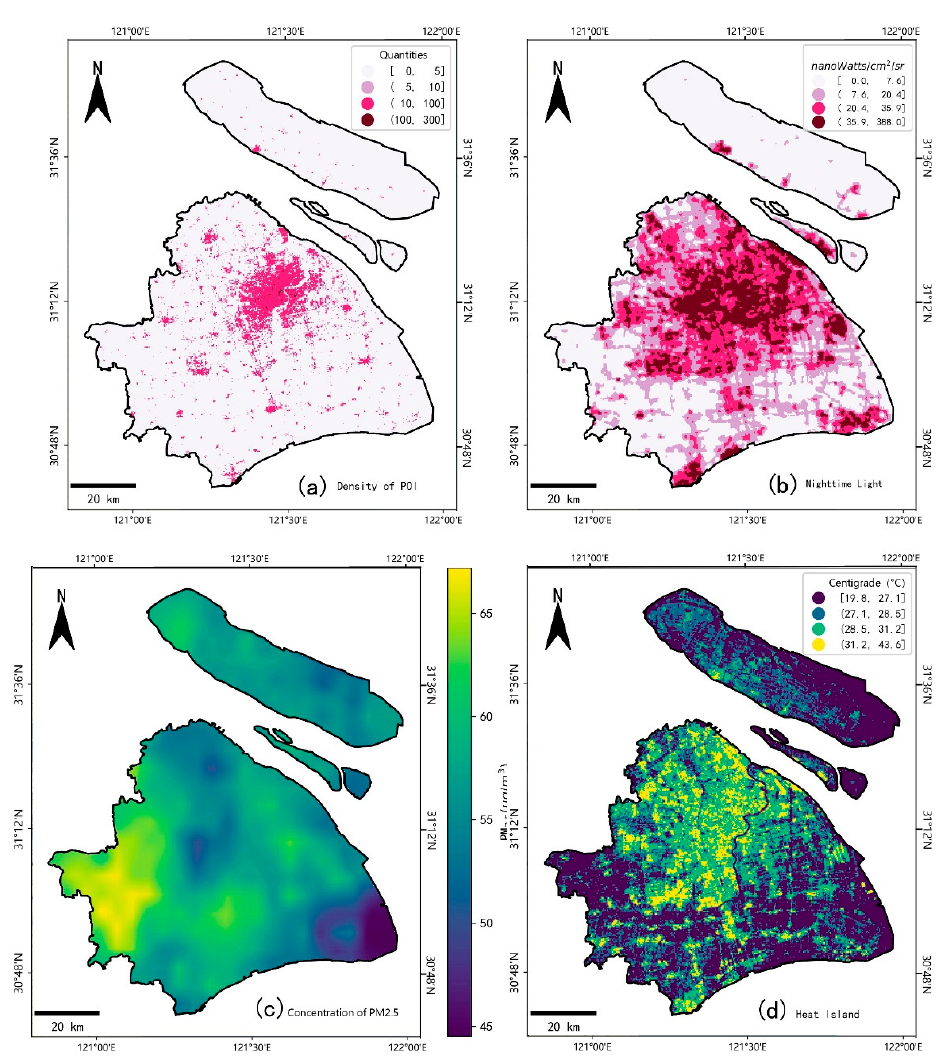
Figure 2. Results of multisource data processing. ( a ) Density of POI. ( b ) Nighttime light intensity. ( c ) PM2.5 concentrations. ( d ) Surface temperature inversion. (3) Data on PM 2.5 concentrations: PM 2.5 concentration data with a global average resolu- tion of 0.01° * 0.01° were retrieved by the Atmospheric Composition Analysis Group of Dalhousie University. The data were estimated by combining the inversion values